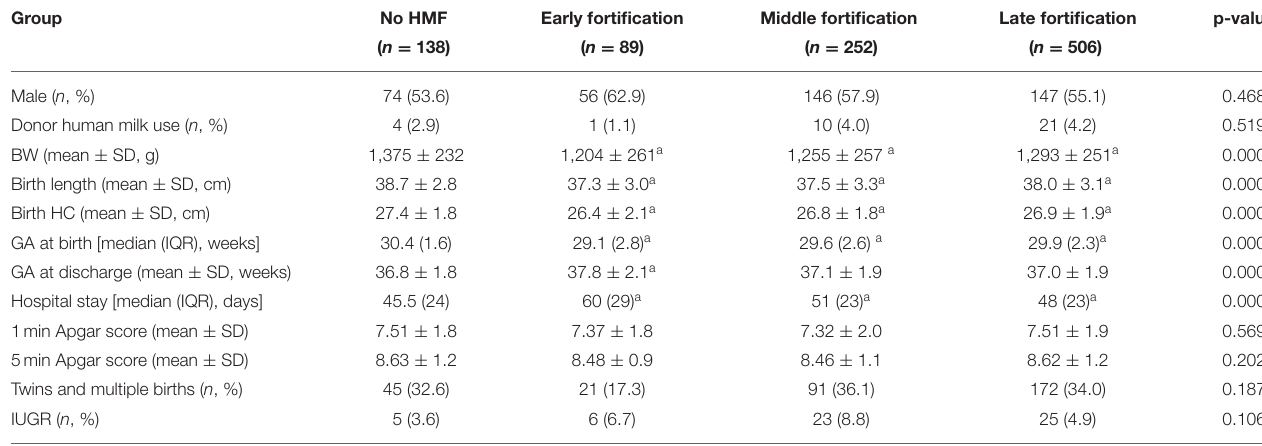
TABLE 1 | Comparison of baseline characteristics.